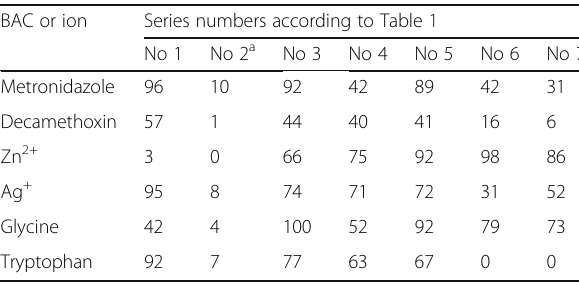
Table 4 BAC maximal release (in %) from the